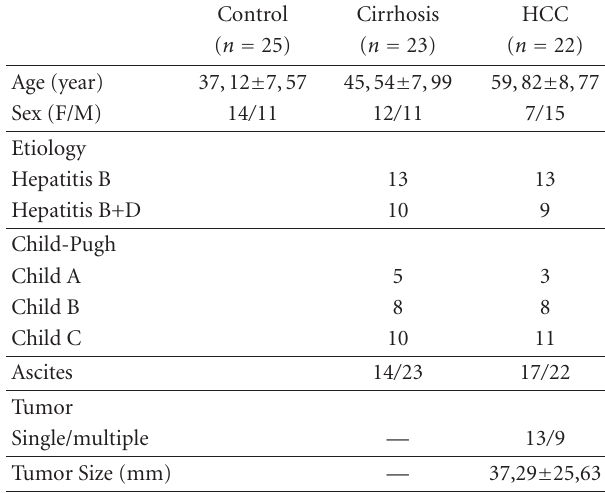
Table 1: Demographic and clinical characteristics of control and patients